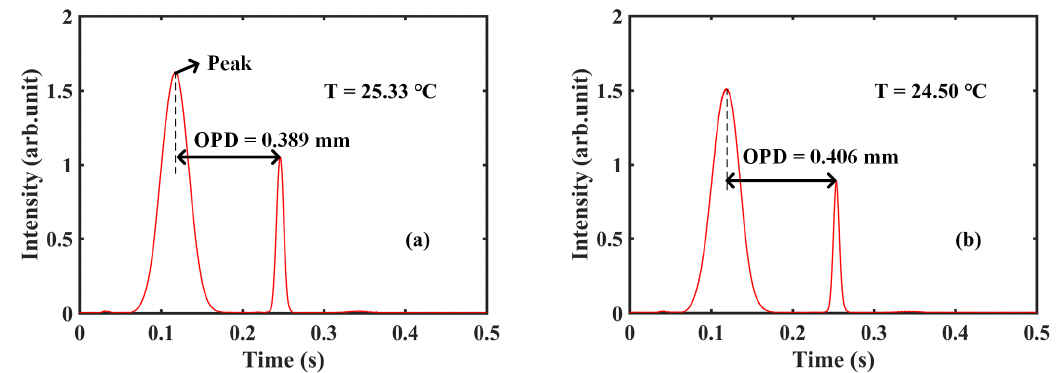
Figure 6. ( a ) Results of the Hilbert transform in 25.33 °C; ( b ) results of the Hilbert transform in 24.50 °C.